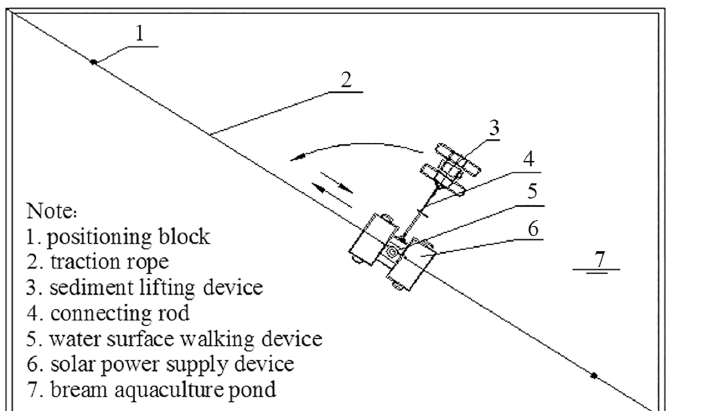
Fig 1. Processing craft of the